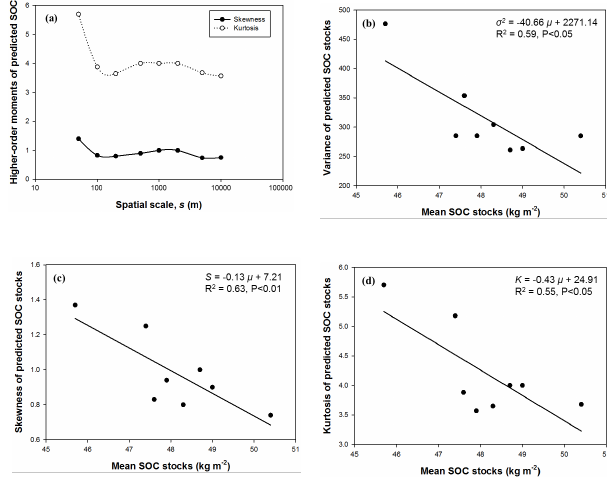
Figure 6. Higher-order moments of predicted SOC stocks as a func- Figure 6: tion of spatial scale (a) , and relationships between predicted mean SOC stocks and its (b) variance, (c) skewness, and (d) kurtosis within the range of predicted mean values of SOC